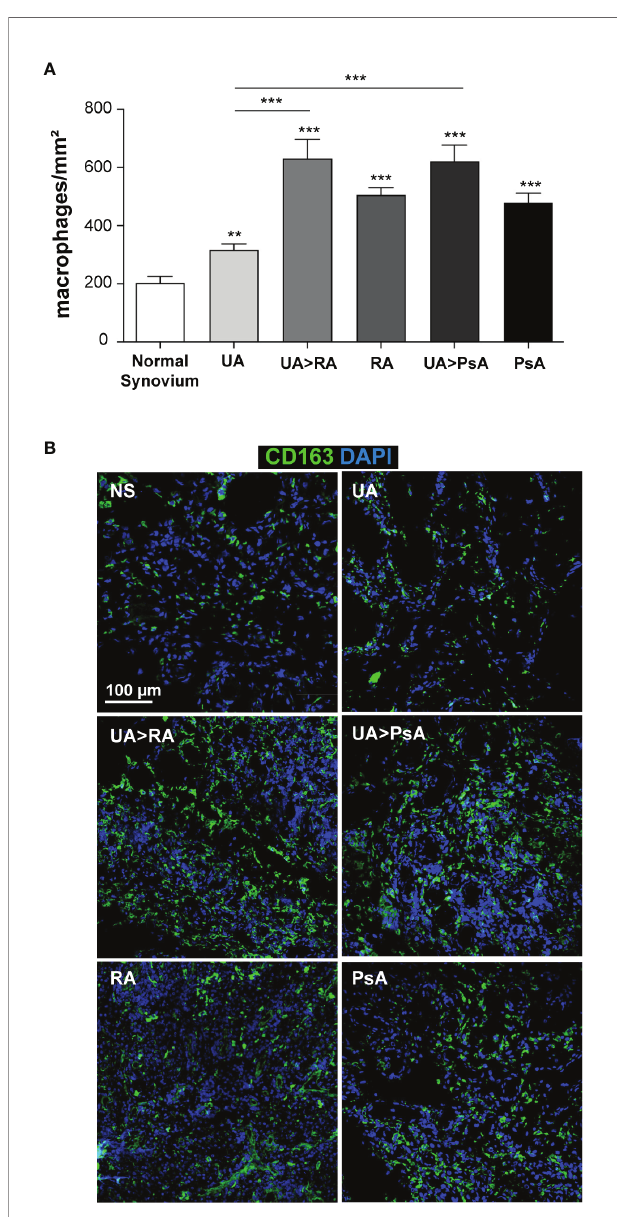
FIGURE 5 | Macrophage density in normal, undifferentiated arthritis, rheumatoid arthritis and psoriatic arthritis synovial tissue. (A) Quanti fi cation of CD163 + macrophages from normal (NS, n=6), undifferentiated arthritis (UA, n=16), undifferentiated arthritis evolving to RA (UA>RA, n=8), undifferentiated arthritis becoming psoriatic arthritis (UA>PsA, n=9), rheumatoid arthritis (RA, n=12), and psoriatic arthritis (PsA, n=10) synovial tissues. The total number of macrophages was normalized based on selected tissue area (mm 2 ). Mean ± SEM is shown. Signi fi cant differences are indicated (** p < 0.01, *** p < 0.001, Mann-Whitney test). (B) Immuno fl uorescence analysis of NS, UA, UA>RA, RA, UA>PsA, and PsA synovial tissues as determined by confocal microscopy using anti-CD163 speci fi c antibody (green); nuclei were counterstained with DAPI (blue). The experiment was carried out in independent samples from each type (six normal synovial tissue controls and eight to 16 remaining synovial tissues) and representative experiments are shown. Scale bars, 100